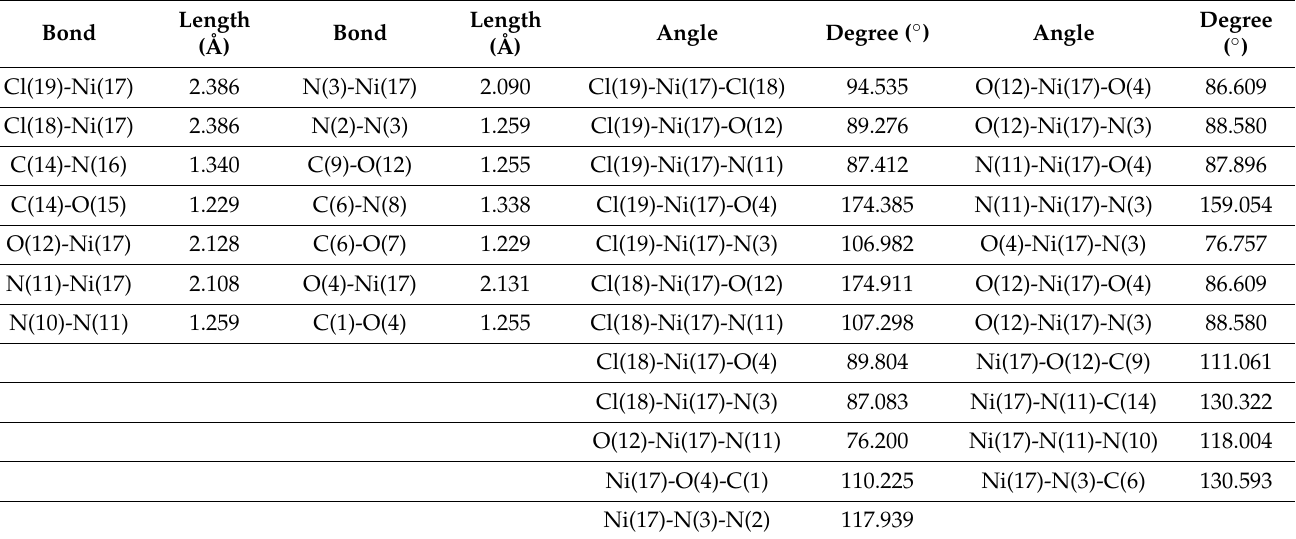
Table 8. Selected bond lengths (Å) and bond angles ( ◦ ) of Ni complex ligand using DFT-method from DMOL 3